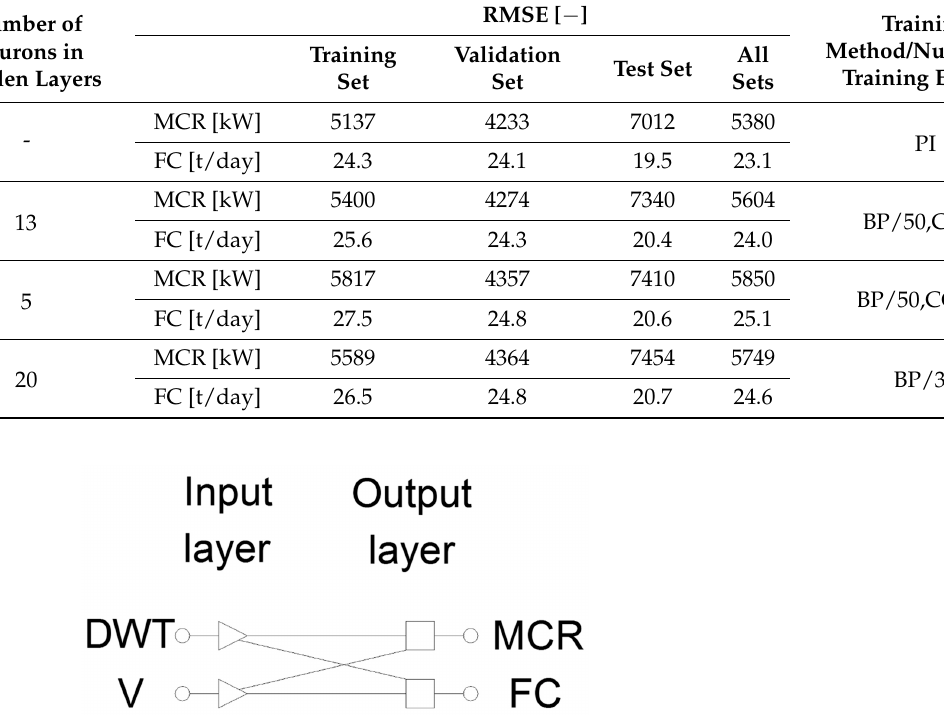
Table 6. An overview of the neural networks that were developed to estimate the engine power and fuel consumption of container ships, where: BP—error back propagation algorithm, CG—conjugate gradient algorithm, PI—pseudo-inverse algorithm and RMSE—root mean square error.